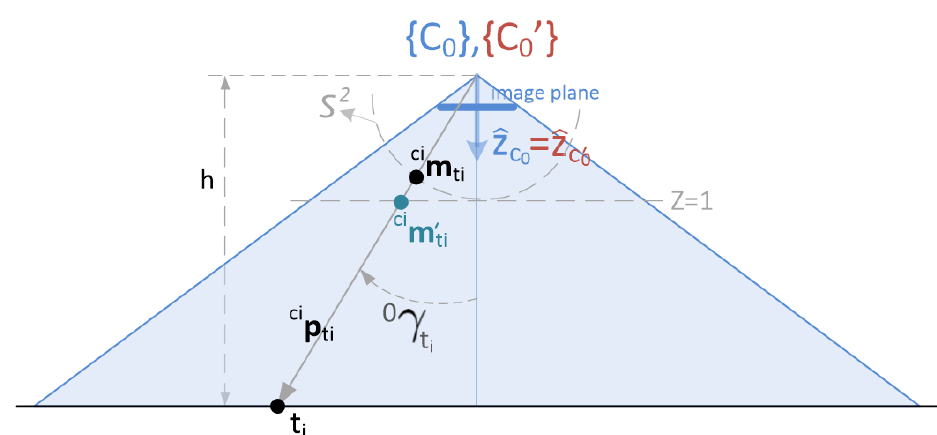
Figure 3. Relation altitude-subtended angle of the projected target